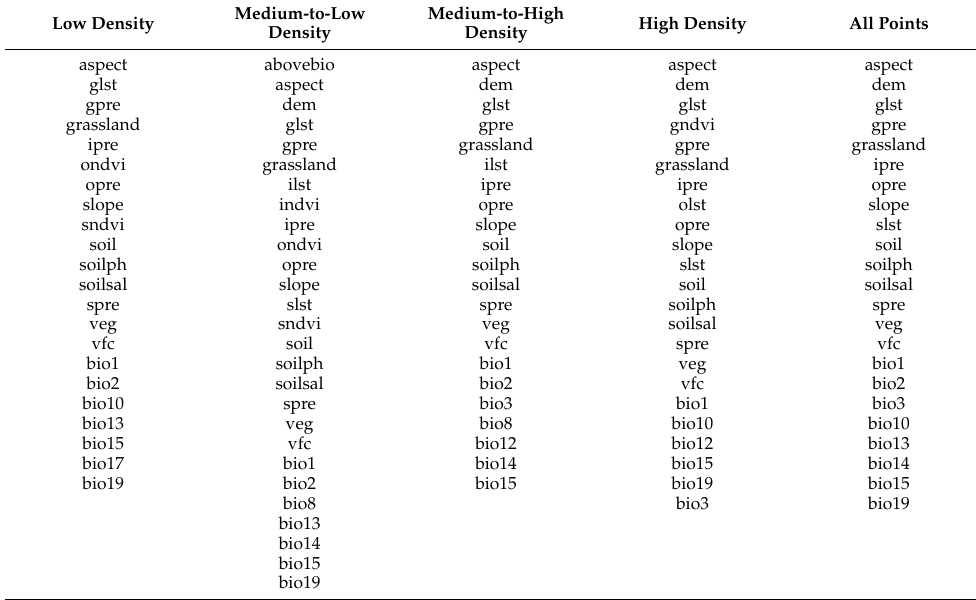
Table 2. The filtered results of the different density levels of the environmental variables. Low Density Medium-to-Low Density Medium-to-High Density All Points aspect abovebio aspect aspect aspect glst